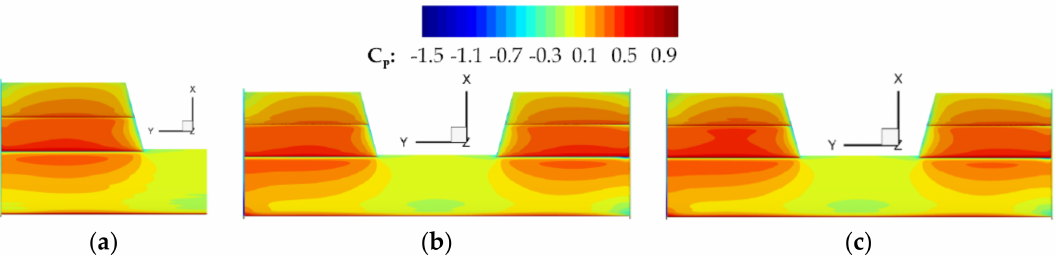
Figure 19. Contours showing the mean pressure coefficient distribution on the pressure surfaces. The stagnation pressure coefficient is (cid:54) = 1 at the inboard and outboard region for the cornering condition; this is because it is calculated on a single reference velocity coinciding with that assigned at the LCoR. ( a ) Straight-line Condition; ( b ) Cornering condition; ( c ) Fixed yaw